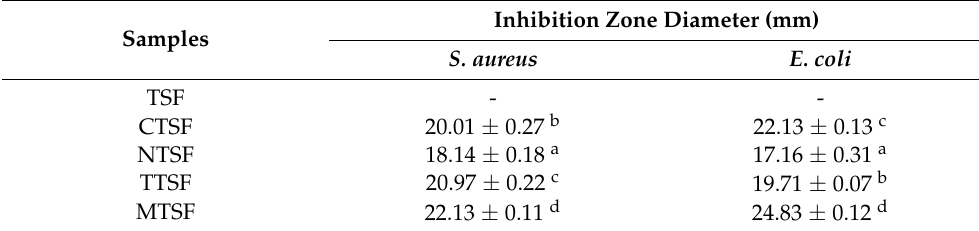
Table 2. Antibacterial activity of biodegradable composite films with and without plant extracts against S. aureus and E. coli .